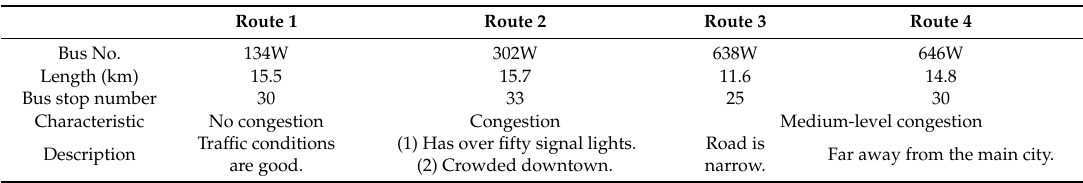
Table 2. Routes Involved in the